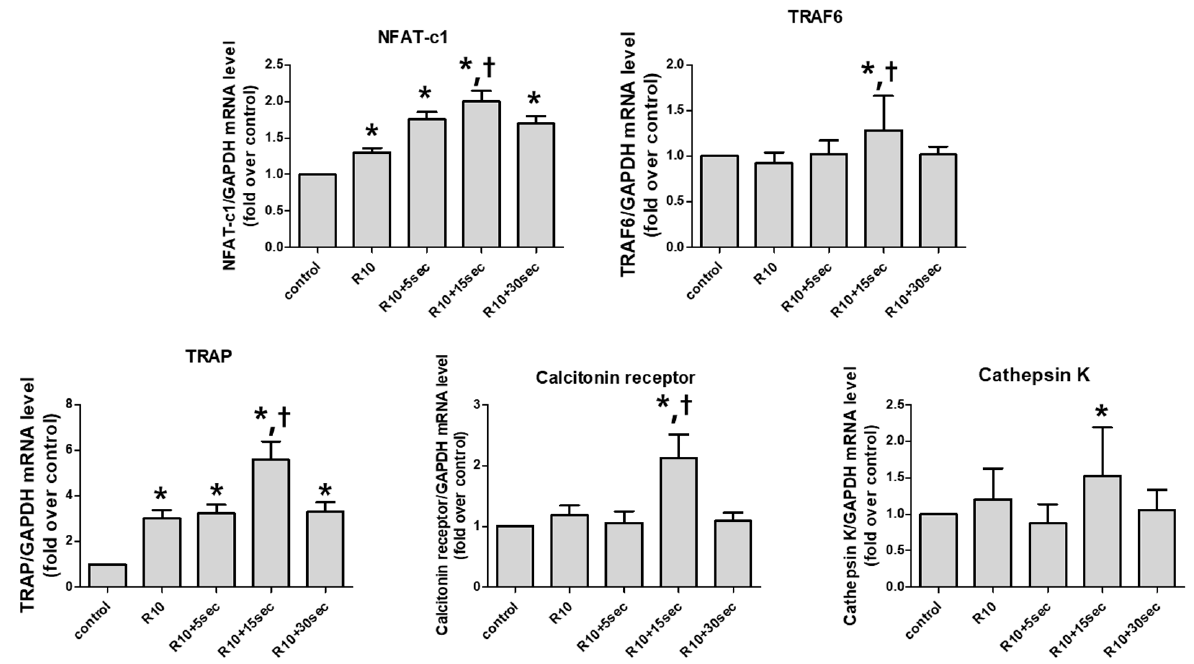
Figure 3. LLLT causes a difference in the expression of osteoclast-forming genes. RAW 264.7 cells were irradiated with LLLT (5~30 s) and incubated for 24 h in the presence of RANKL (10 ng/mL), then total RNA was extracted, and gene expression was analyzed by real-time RT-PCR. Each value represents the mean ± S.D. * p < compared to control group; compared to RANKL alone, † p <0.05.